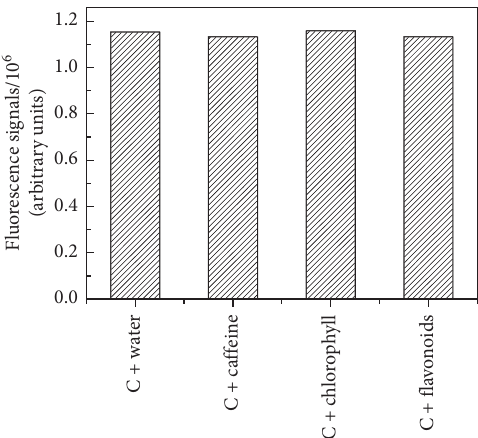
Figure 6: Fluorescence response of catechin (C) mixed with other interfering substances in tea.